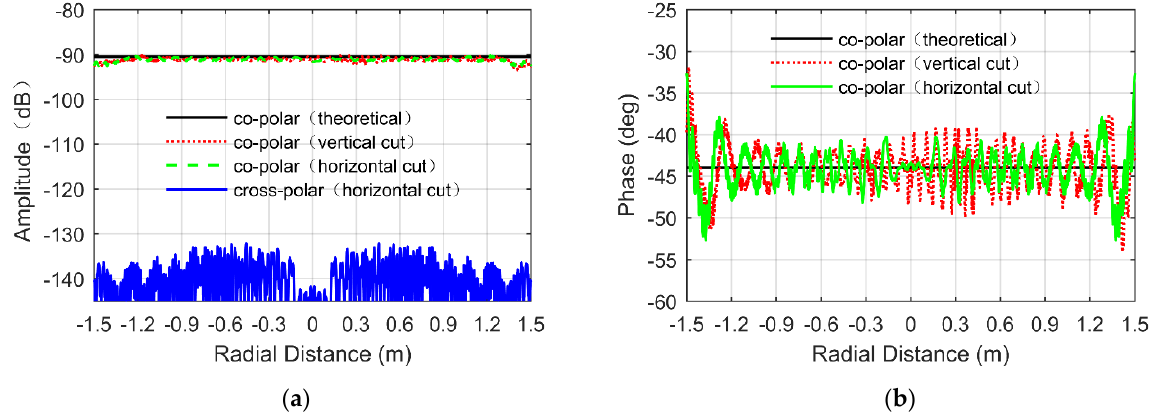
Figure 6. PO + PTD one-dimensional simulated results of the designed tri-reflector CATR with standard quadric surfaces when illuminated by a shaped feed at 300 GHz. ( a ) Co- and cross-polar amplitude; ( b ) co-polar phase.